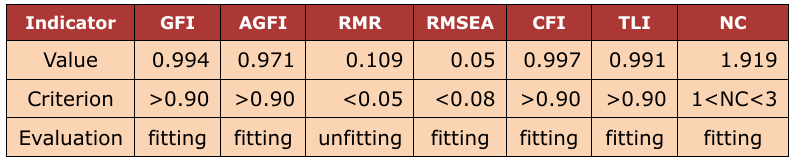
Table 5. Evaluation of primary indicators for the overall fitness